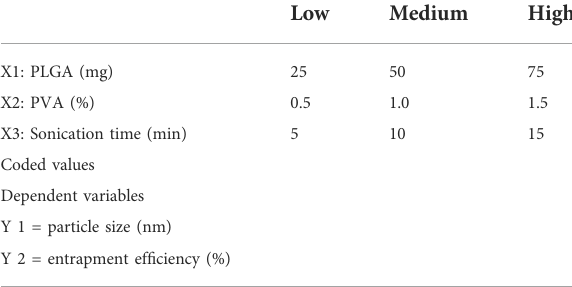
TABLE 1 Independent variable and their levels in Box – Behnken design.